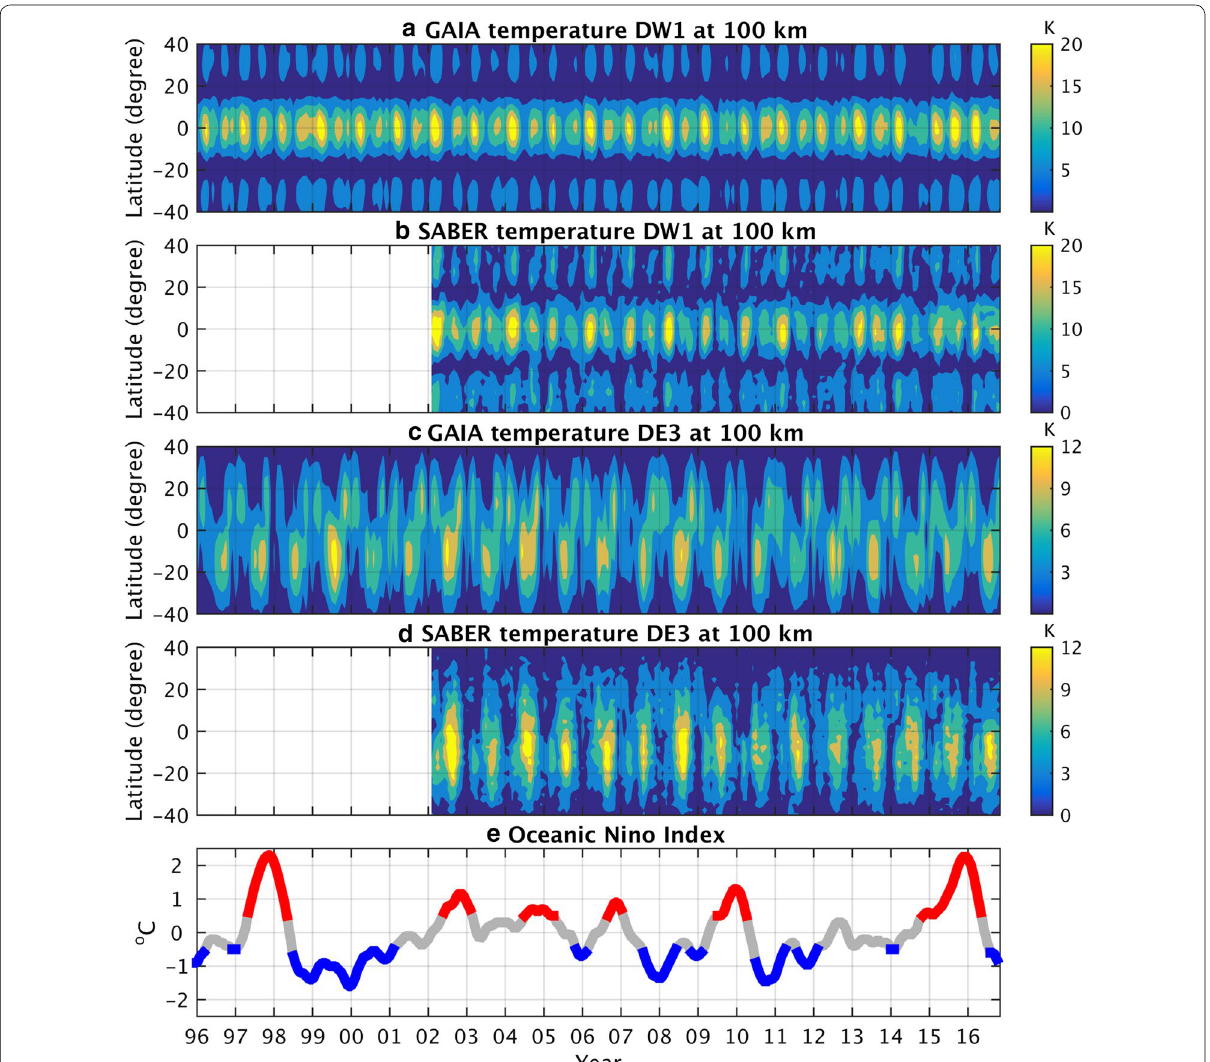
Fig. 1 Amplitude of the two dominant diurnal tides DW1 (diurnal westward wavenumber 1) and DE3 (diurnal eastward wavenumber 3) from GAIA and TIMED/SABER temperature at an altitude of 100 km. (Bottom) Red and blue (exceeding the threshold of (ONI) indicate the ENSO (El Niño–Southern Oscillation) warm and cold